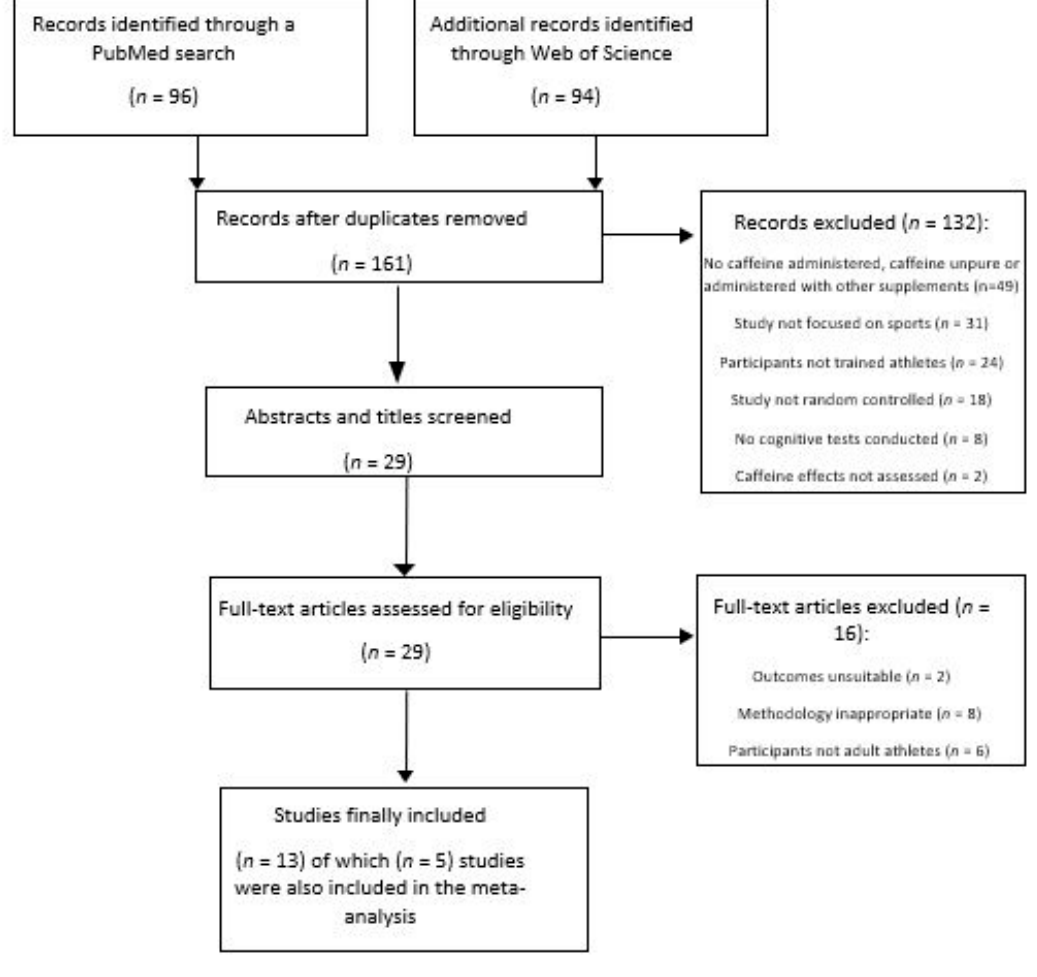
Figure 1. Selection of studies.